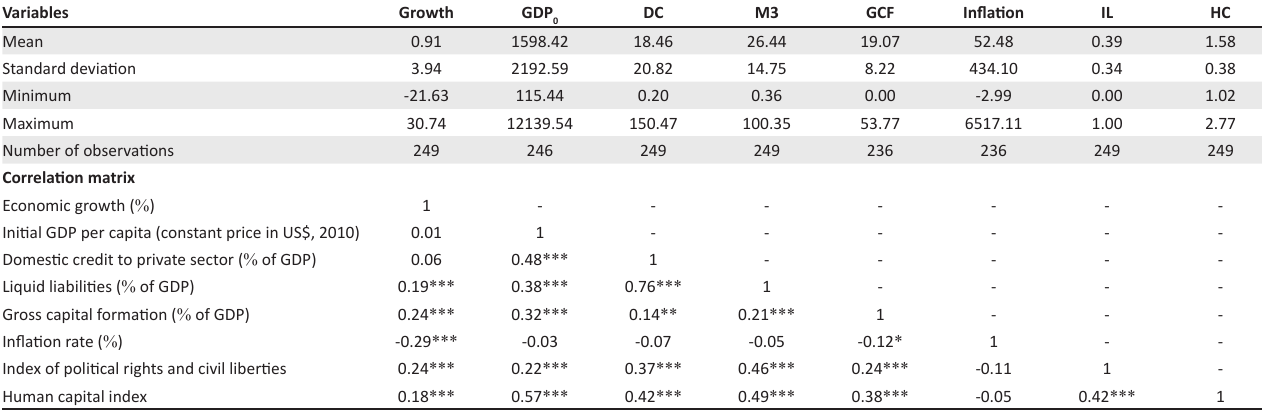
TABLE 2: Descriptive statistics and correlation matrix. Variables